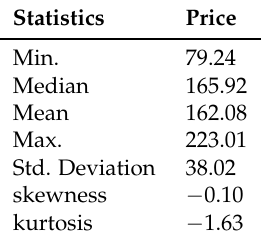
Table 2. Summary statistics of price with inflation index.